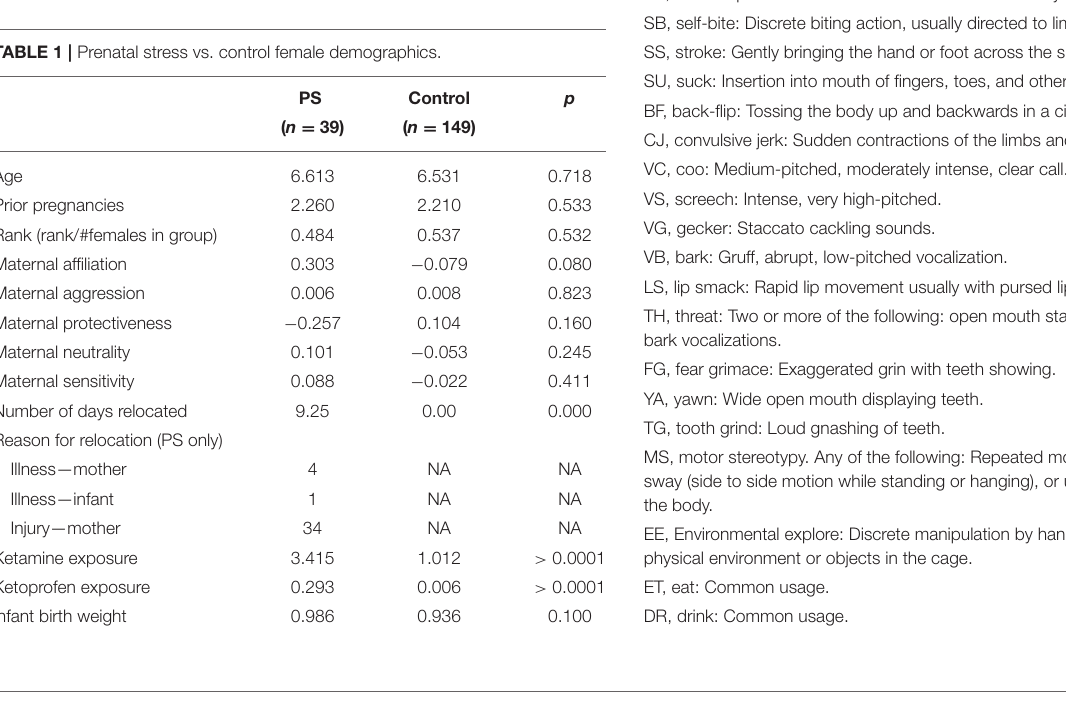
TABLE 2 | Maternal behavior transaction theme definitions.